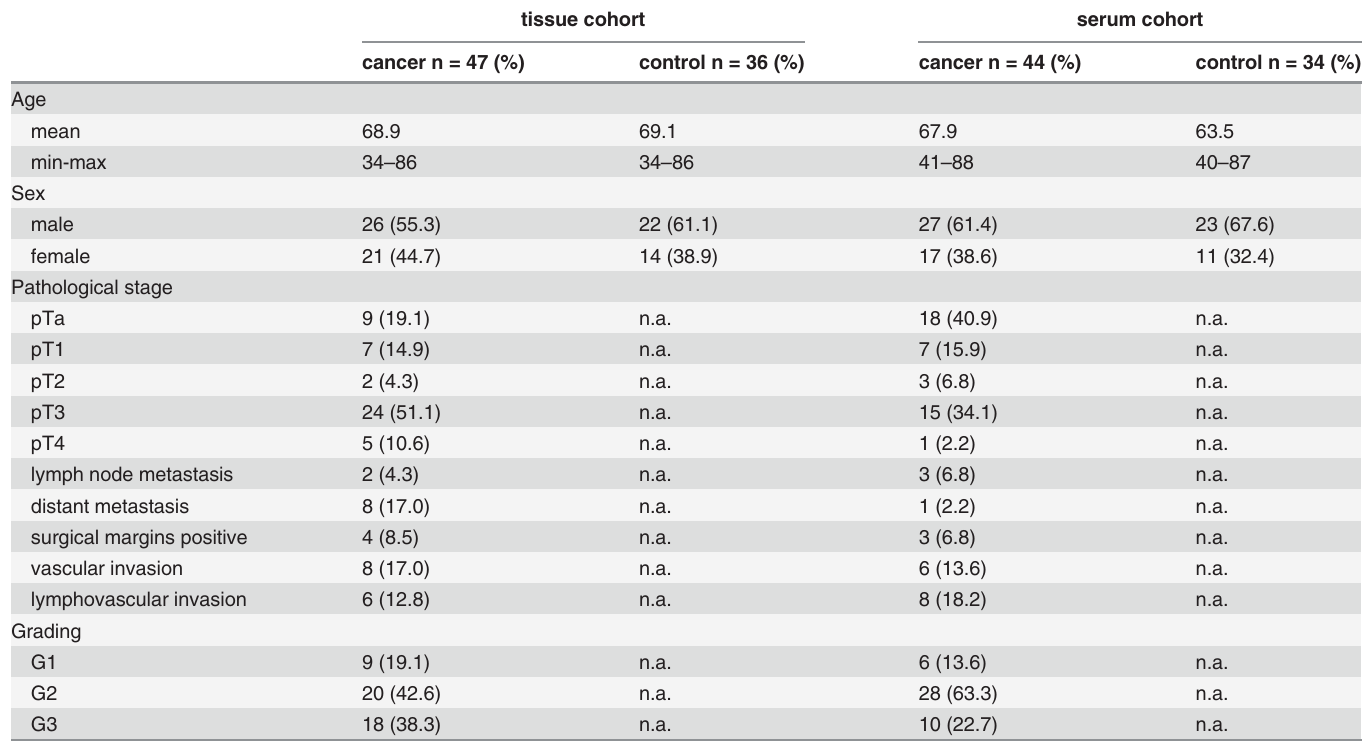
Table 1. Summary of clinical-pathological parameters of the study